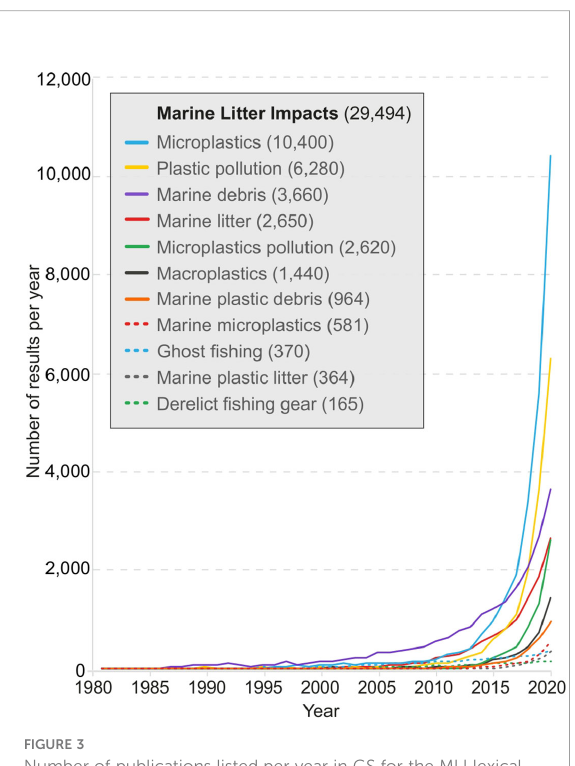
FIGURE 2 Number of publications per year listed in GS for the SFH lexical group, between 1981-2020. CWC terms (deep-water corals, deep-sea corals, cold-water corals) were plotted individually and as a combined count.